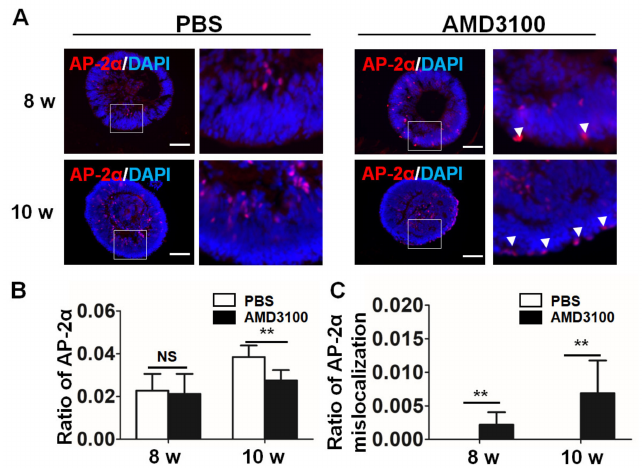
Figure 7. CXCR4 blockade leads to a decrease in the number of amacrine cells and their mislocal- ization in retinal organoids. ( A ) Amacrine cells were stained for AP-2 α from 8 weeks to 10 weeks of differentiation, and AP-2 α staining was mislocalized in the AMD3100 treatment group (white arrowhead). ( B ) The relative ratio of AP-2 α -positive cells to all cells (nuclei were stained with DAPI) significantly decreased in the AMD3100 group (** p < 0.01, NS: Not Significant, p > 0.1, n = 15). ( C ) The relative ratio of AP-2 α -positive cells to all cells (nuclei were stained with DAPI) located in the INBL significantly increased in the AMD3100 group (** p < 0.01, n = 15). Scale bars: 100 µ m.